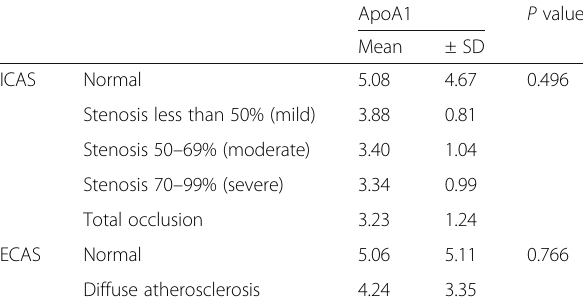
Table 2 Correlation between ApoA1 level and